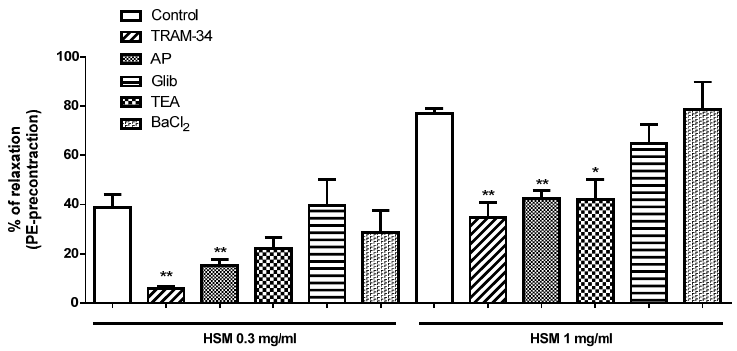
Figure 7. The effects of TRAM-34 (1 µ M), apamin (AP, 1 µ M), glibenclamide (Glib, 10 µ M), tetraethylamonium (TEA, 0.5 mM) and BaCl 2 (30 mM) on the vasorelaxant response of H. stoechas extract (HSM, 0.3 and 1 mg/mL) in isolated rat rings precontracted with PE (Interaction: F = 0.68, p = 0.6426; Dose: F = 11.08, p < 0.0001, Way: F = 61.59, p < 0.0001). Data points are mean ± SEM ( n = 6–8). * p < 0.05 and ** p < 0.01 vs. control.